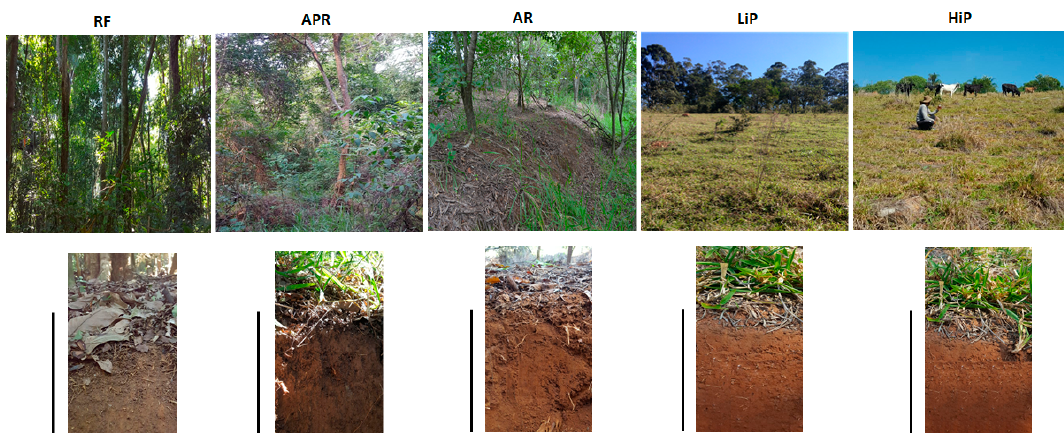
Figure 2. Pictures showing the vegetation cover and the Ultisol top-soil profile for each study site. The black lines in each top-soil profile represent 0.2 m scale. RF, Reference Forest; APR, Assisted